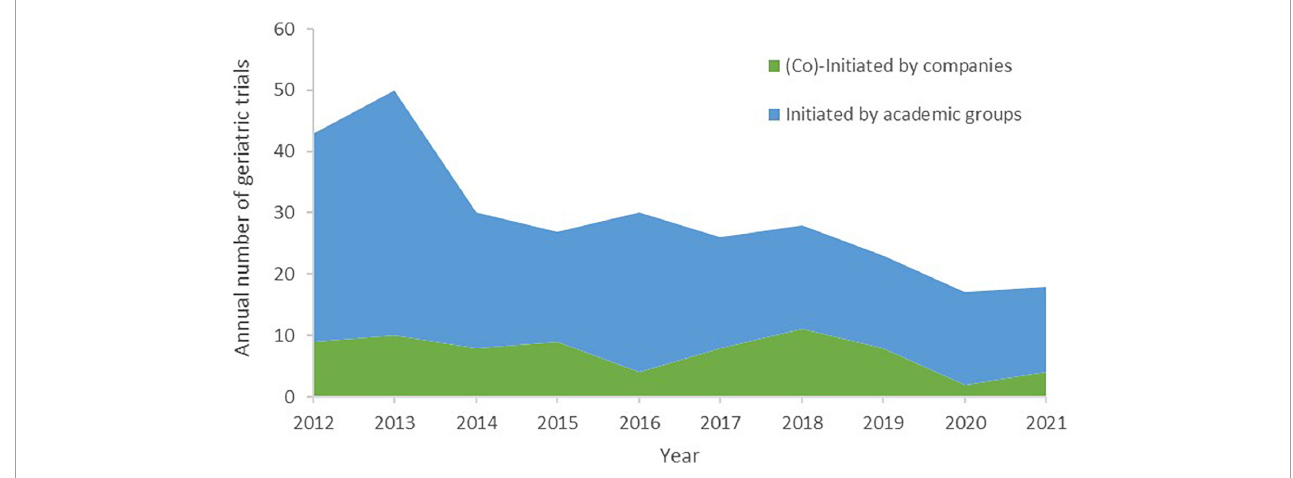
FIGURE1 Annual number of initiated geriatric drug trials on solid tumor by sponsor type,